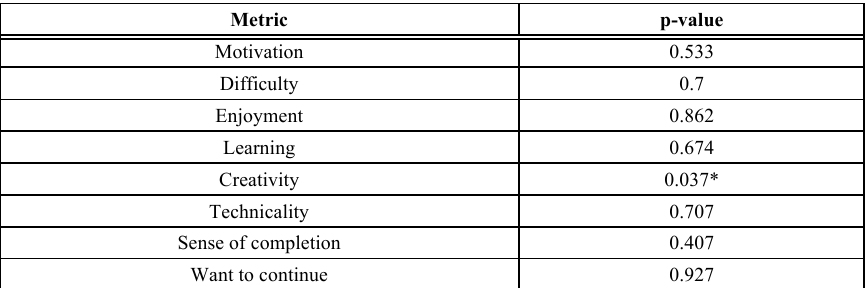
Table 1. P-values for variation between STEAM and non-STEAM lessons per self reported experience